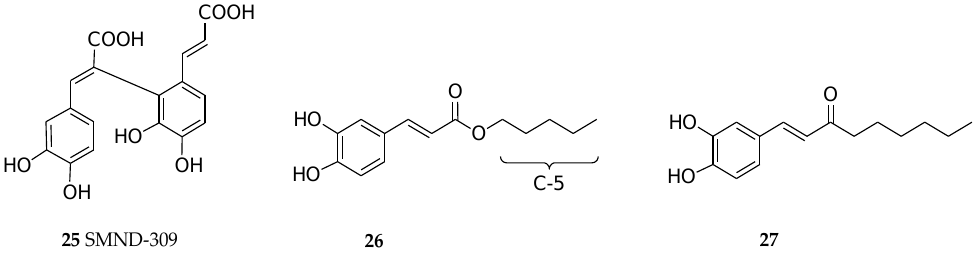
Figure 4. Structures of some synthetic analogues with proven biological effects related to dementia. SMDD ( 25 ) is a caffeic acid dimer that does not involve an ester bond but rather a C-C bridge. The C-5 chain derivative, compound 26 , was found to have an optimum structure in antioxidant and Aβ aggregation inhibition studies from studies on derivatives including C-3 to C-9 chain length, while compound 27 was a prototype lead compound that does not have an ester linkage. Table 1. In vitro neuroprotective effects of Salvianolic acids.